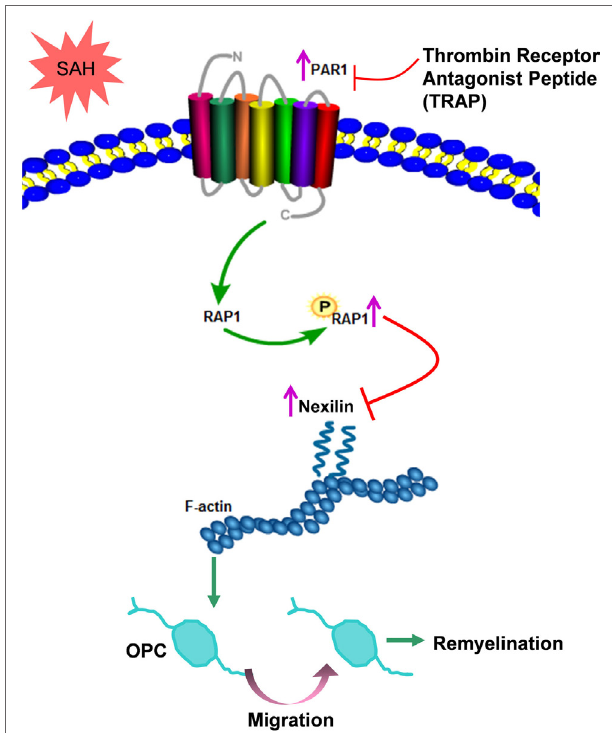
FigUre 8 | Schematic diagram of the present study. After subarachnoid hemorrhage (SAH), elevated nexilin levels facilitate F-actin rearrangement and then promote oligodendrocyte progenitor cell (OPC) migration and remyelination. Nexilin expression is negatively regulated by the activated thrombin receptor protease-activated receptor 1 (PAR1) on the OPC membrane, which is followed by the activation of downstream Ras- proximate-1 (RAP1) and the promotion of RAP1 phosphorylation. The suppression of PAR1 by thrombin receptor antagonist peptide (TRAP) inhibits PAR1 signaling but enhances nexilin and promotes OPC migration and remyelination after